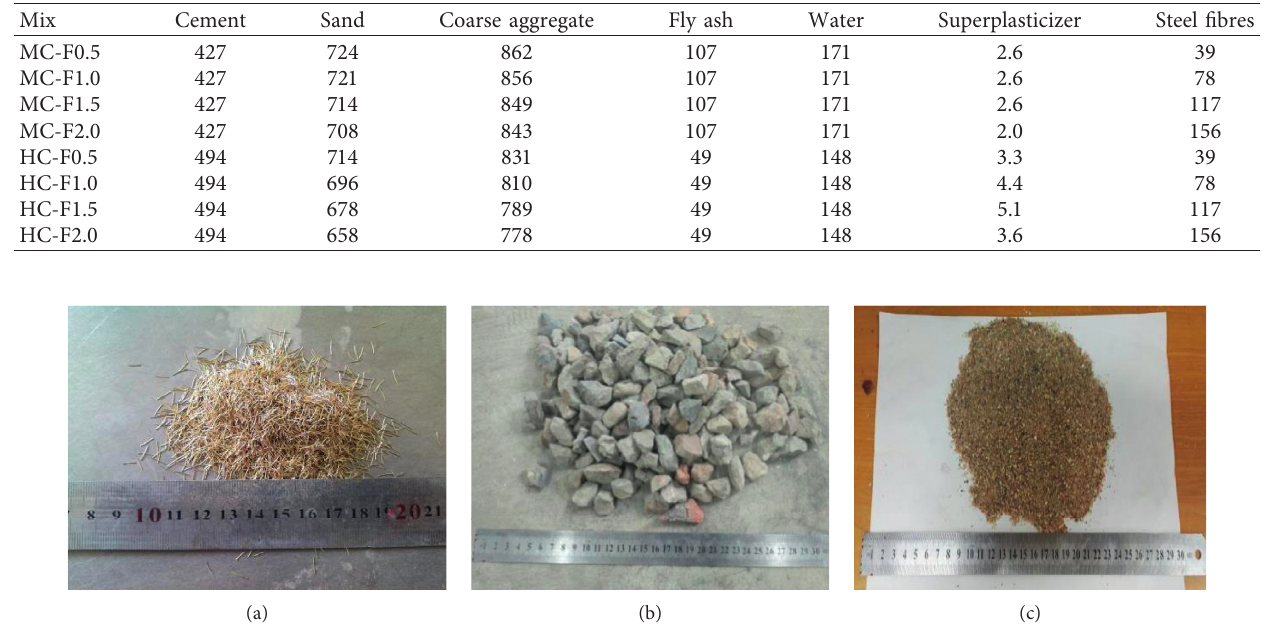
Table 1: Mix proportions of SFRSCC (kg/m 3 ).